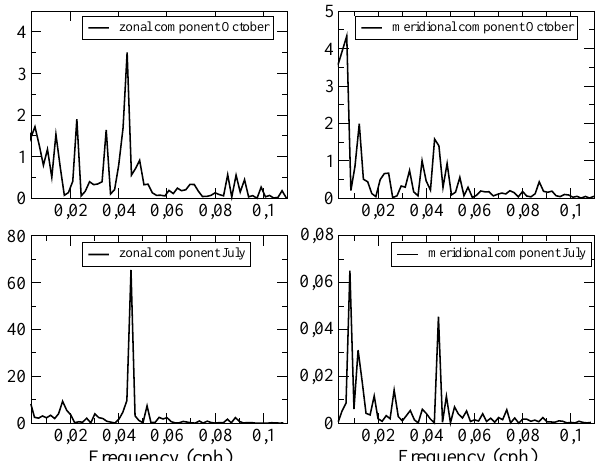
Fig. 3. Spectra for the zonal (left panels) and meridional compo- nents (right panels) of the surface velocity field (m 2 s − 1 ) in October (top) and July